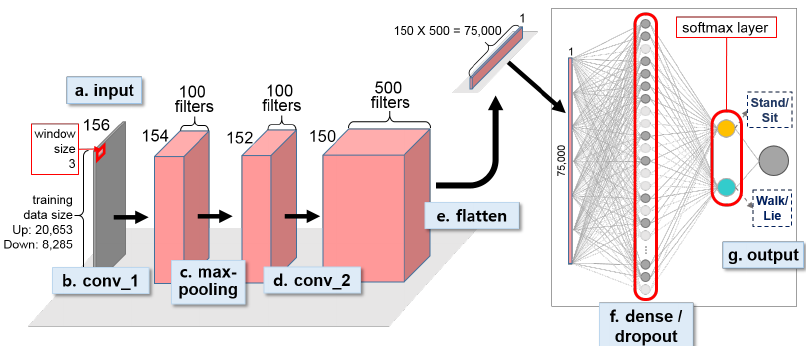
Figure 9. Second-stage 1D CNN for classifying individual activities for OPPORTUNITY dataset. Two identically designed 1D CNNs were constructed to distinguish Stand from Walk and Sit from Lie.